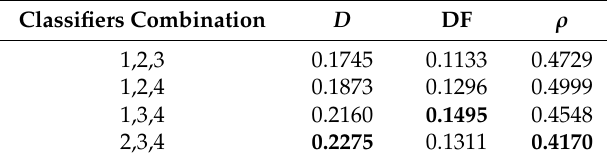
Table 2. The diversity value (in terms of D, DF and ρ ). The greatest diversity is marked in bold italics.